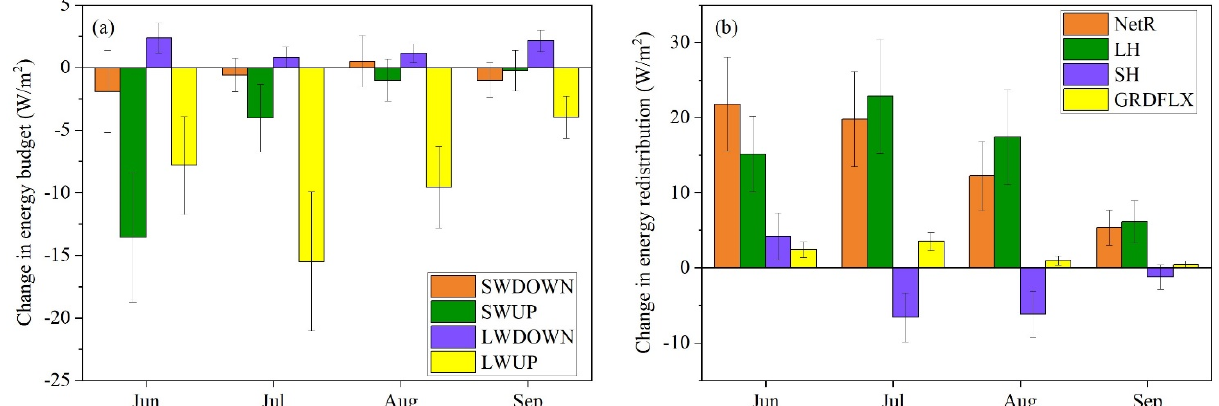
Figure 9. Differences (SEN-CTL) in simulated regional means of ( a ) incoming shortwave radiation (SWDOWN), outcoming shortwave radiation (SWUP), incoming longwave radiation (LWDOWN), outcoming longwave radiation (LWUP), ( b ) net radiation (NetR), latent heat flux (LH), sensible heat flux (SH), and ground heat flux (GRDFLX) for the grids with dominant land use type converted from saline-alkali land to wetland for June, July, August, September of western Jilin. The error bar is the standard deviation of changes in each variable.